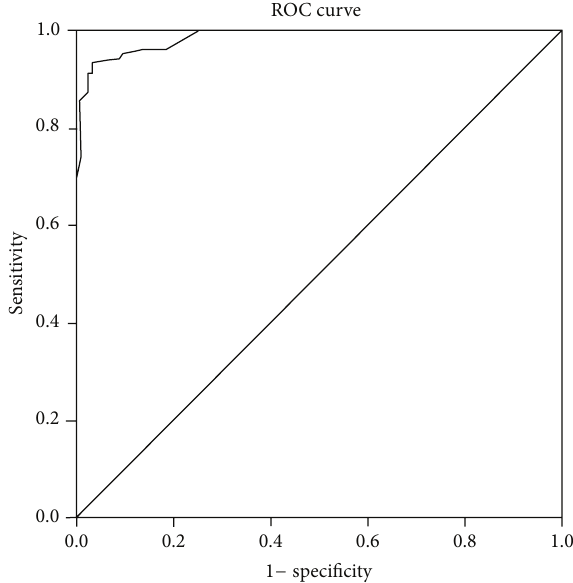
Figure 3: ROC curve of the sensitivity and specificity of the AQ- Adult score. Area under the curve = .99.